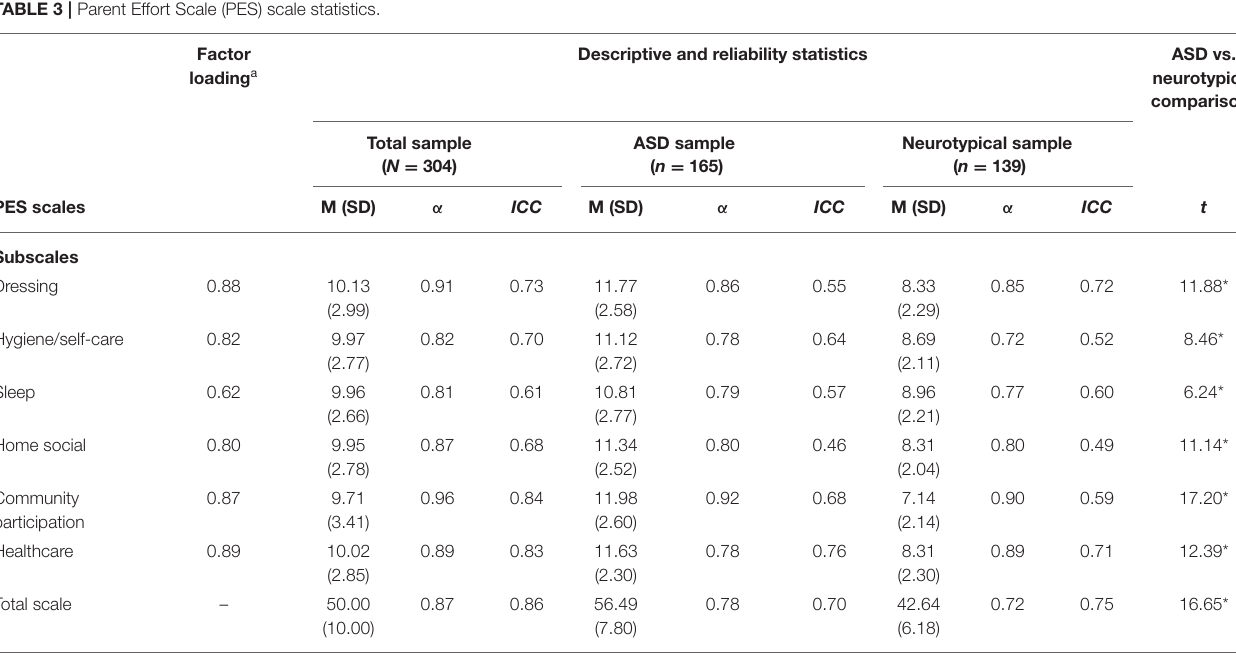
TABLE 3 | Parent Effort Scale (PES) scale